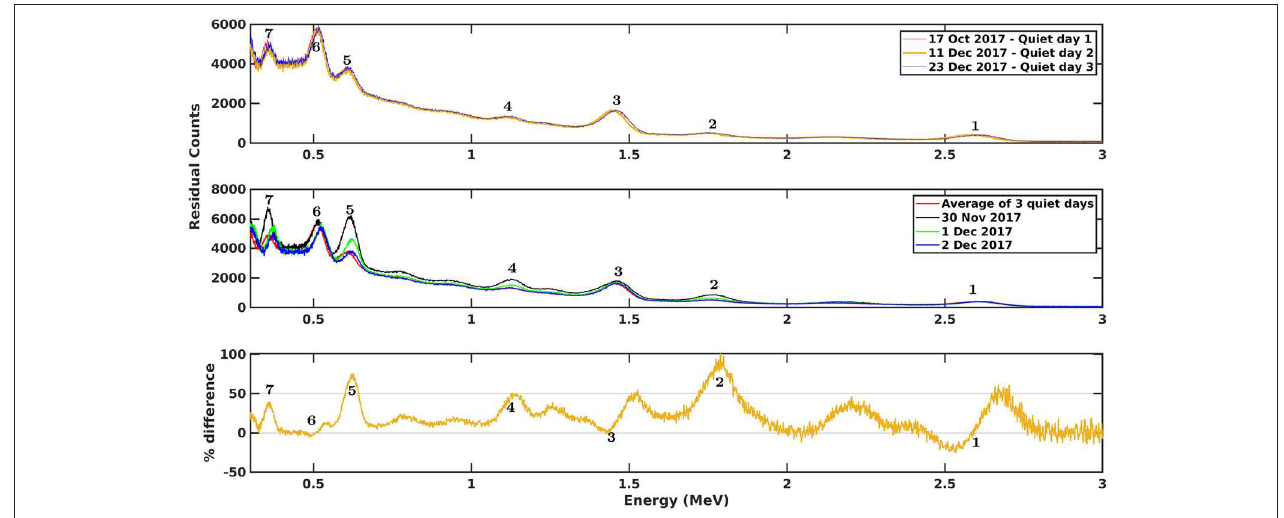
FIGURE 8 | In the top panel, quiet weather spectra accumulated for a complete day are presented for three different days. In the middle panel, similar spectra on 30 November, 1 and 2 December 2017 are compared with quiet weather condition; the corresponding residual counts are shown on y-axis. In the bottom panel, % difference between quiet weather condition and 30 November 2017 with respect to the quiet time values is depicted (for energy of peaks, refer Table 2